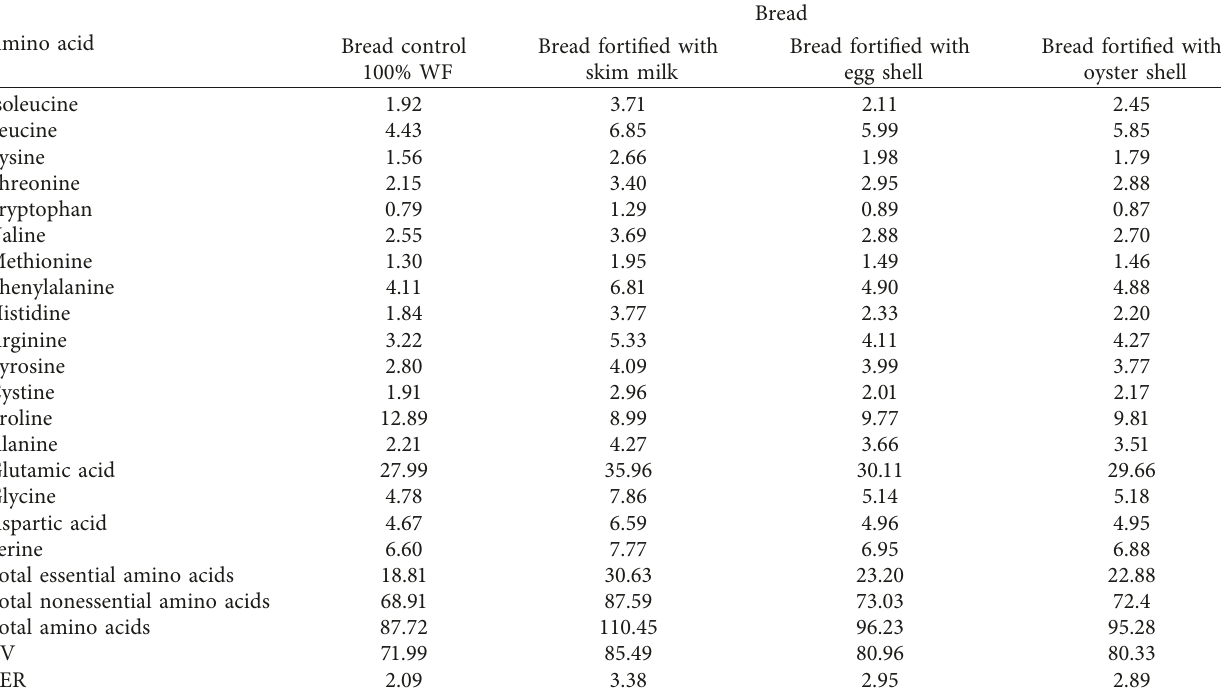
Table 8: Amino acid contents, PER, and BV of breads fortified with skim milk and egg shell and oyster shell powders. Amino acid